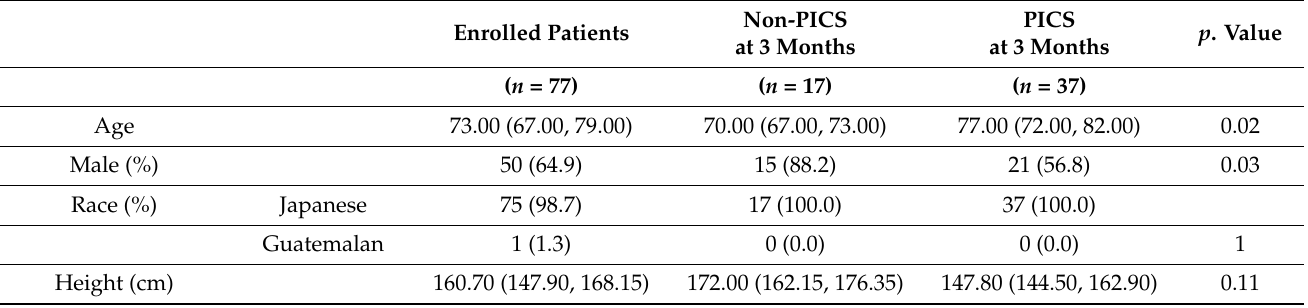
Table 1. Characteristics, treatment of sepsis, outcome, PICS assessments of the patients in the study. Enrolled